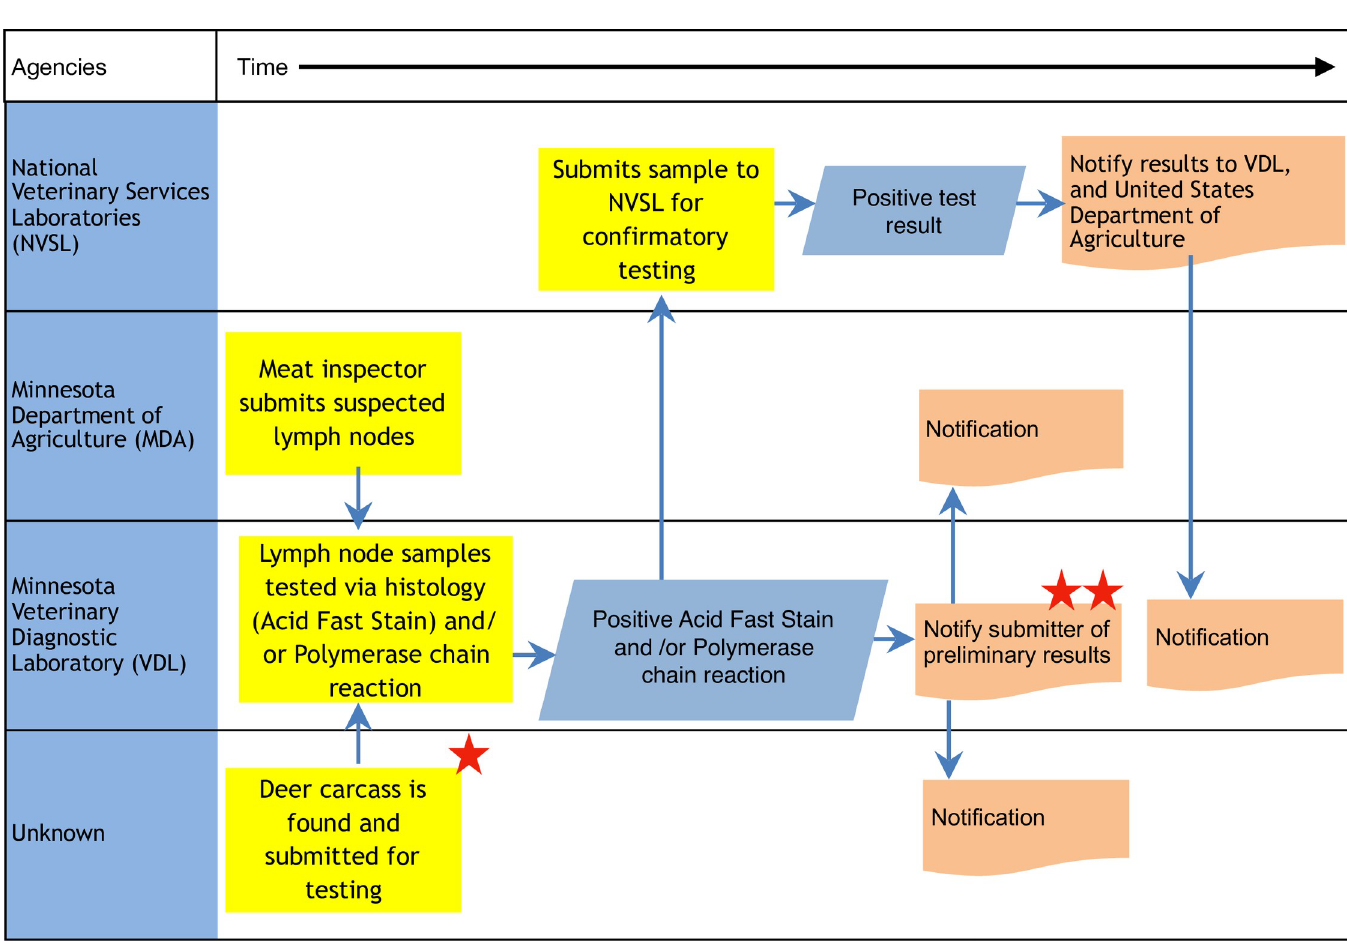
Fig 2. Swimlane map example. Close-up of a swimlane map describing an inter-agency response to a bovine tuberculosis outbreak. Left column lists the involved agencies. Yellow boxes represent actions taken by agency representatives, blue boxes are the results of these actions and orange boxes are notifications. Arrows represent connections between stakeholders and stars are used to mark identified discrepancies: � Who sends the deer carcass for testing? �� Does VDL inform anyone else of preliminary positive results?